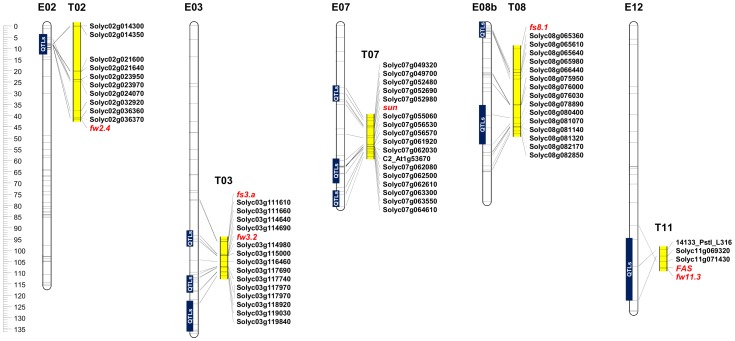
Synteny between eggplant chromosomes E2, E3, E7, E8b and E12 and parts of tomato chromosomes T2, T3, T7, T8 and T11.The physical locations of the tomato genes FW2.4, fs3.a, fw3.2, sun, fs8.1, FAS and fw11.3 are shown in italics and in red. ‘QTL’ shown in a blue box indicate a cluster of eggplant yield, fruit dimension and weight QTL. The scale on the left indicates the length of eggplant chromosomes in cM, while distances on the tomato chromosome segments derived from their physical position on the genome [54].